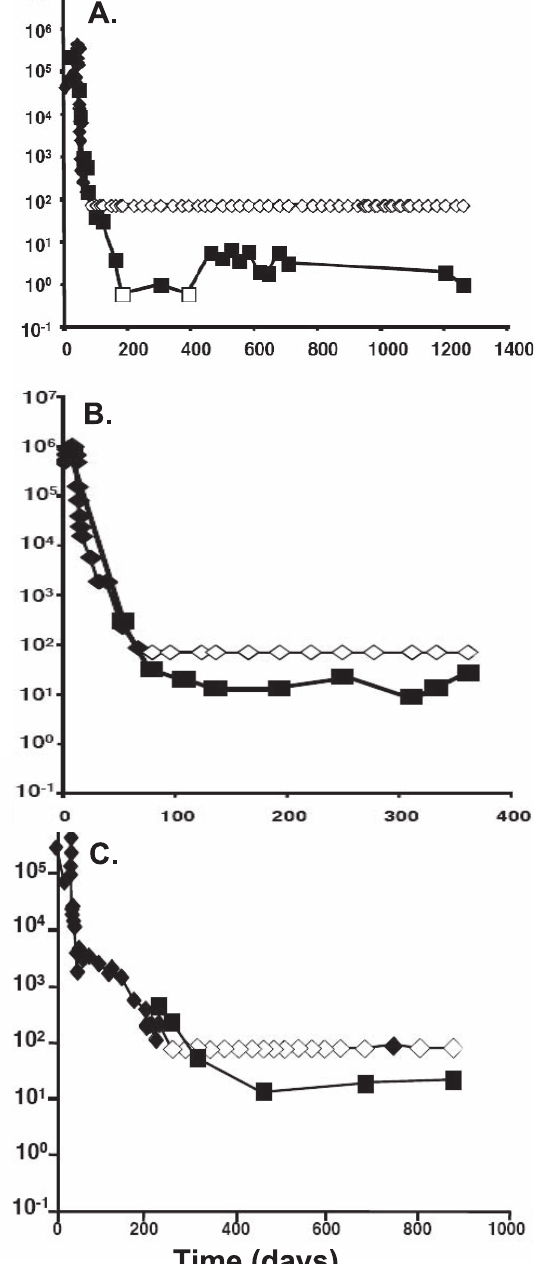
Figure 1. Decline and Stable Persistence of Plasma HIV-1 RNA in Patients Suppressed on Antiretroviral Therapy Plasma from patients initiating antiretroviral therapy with stavudine þ lamivudine þ efavirenz (patients A and B) or stavudine þ lamivudine þ indinavir þ nevirapine (patient C) was assayed by bDNA (diamonds) and SCA (squares). Levels of virus above the limit of detection for each assay are shown by filled symbols; levels below this limit are shown by hollow symbols plotted at the assay limit.